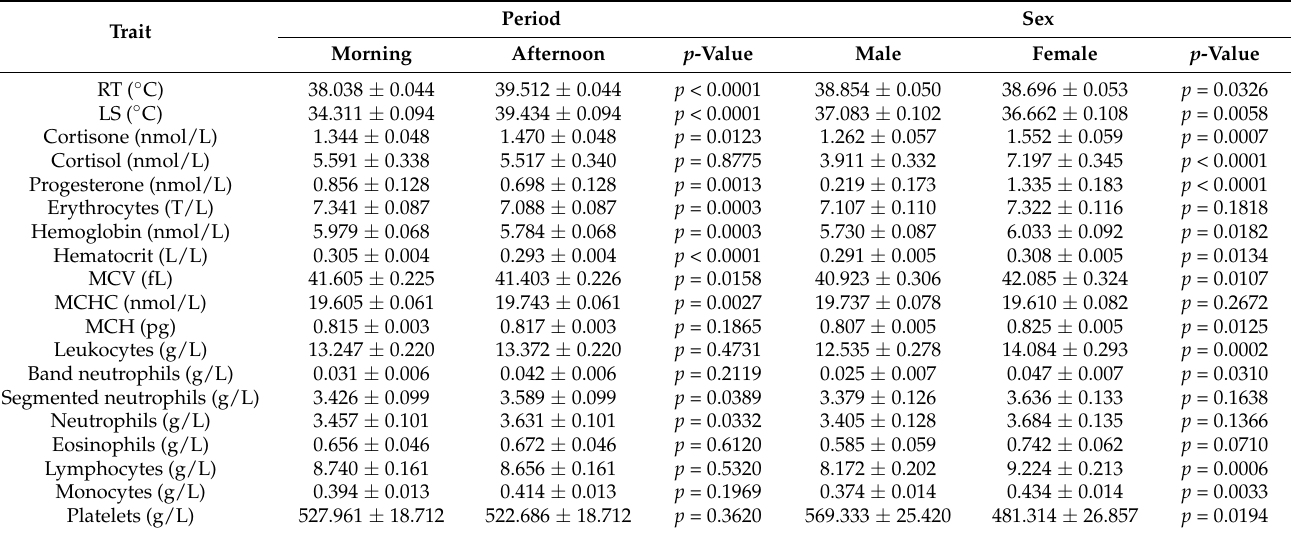
Figure 2. The least square means obtained for the superficial temperature of the lower side of the body (LS) obtained by infrared thermography ( p < 0.0001), cortisol ( p < 0.05), and eosinophils ( p < 0.05) according to sex and period interaction. Table 5. Least square means the physiological, hormonal, and hematological traits observed in male and female Caracu cattle in the morning and in afternoon